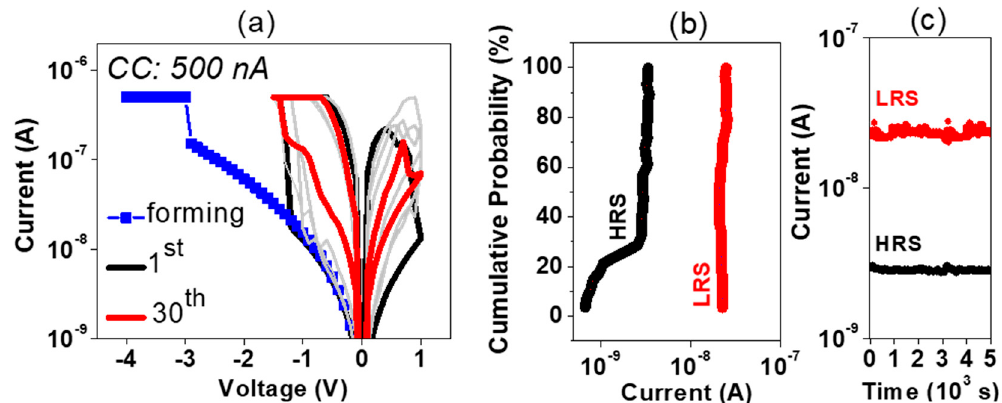
Figure 2. I–V sweeps of forming with a current compliance (CC) of 500 nA (blue squares) and 1 st (black) and 30 th (red) cycles, as well as a few intermediate cycles in grey ( a ), corresponding distribution of resistance states ( b ) and retention over 5 × 10 3 s ( c ).